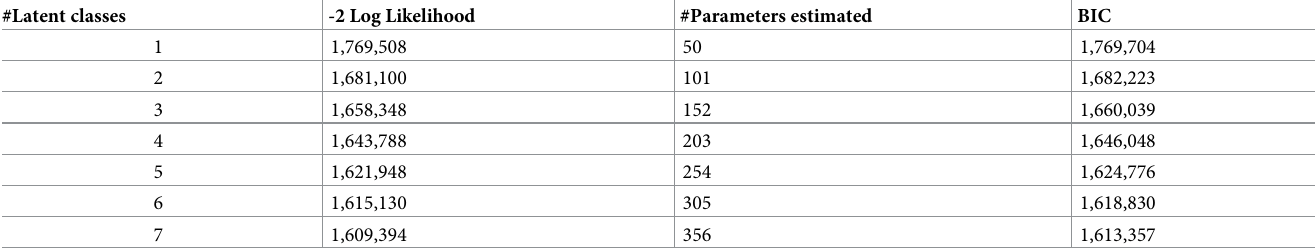
Table 2. Fit indices of mixture distribution IRT models: 1–7 class solution based on 29 medical conditions (N = 68,400